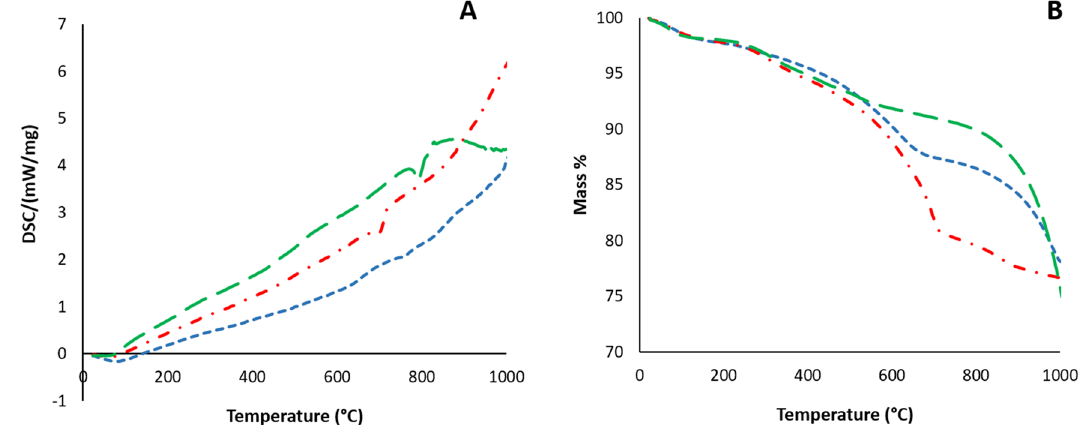
Figure 4. Thermal analysis of Tekirghiol (blue dashed line), Amara (red dashed line) and Ursu (green dashed line) sapropels by differential scanning calorimetry ( A ) and thermogravimetric analysis ( B ).